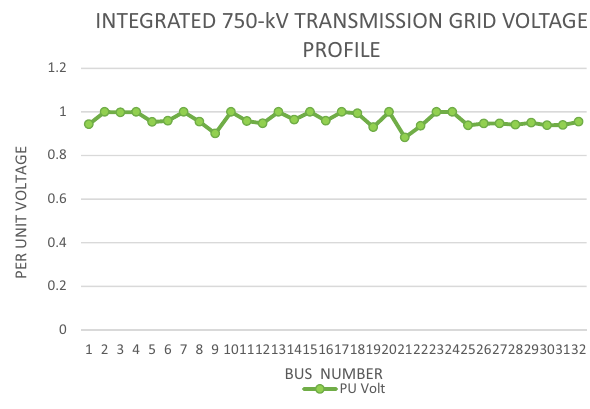
Fig. 10 Voltage profile of 750-kV super gird